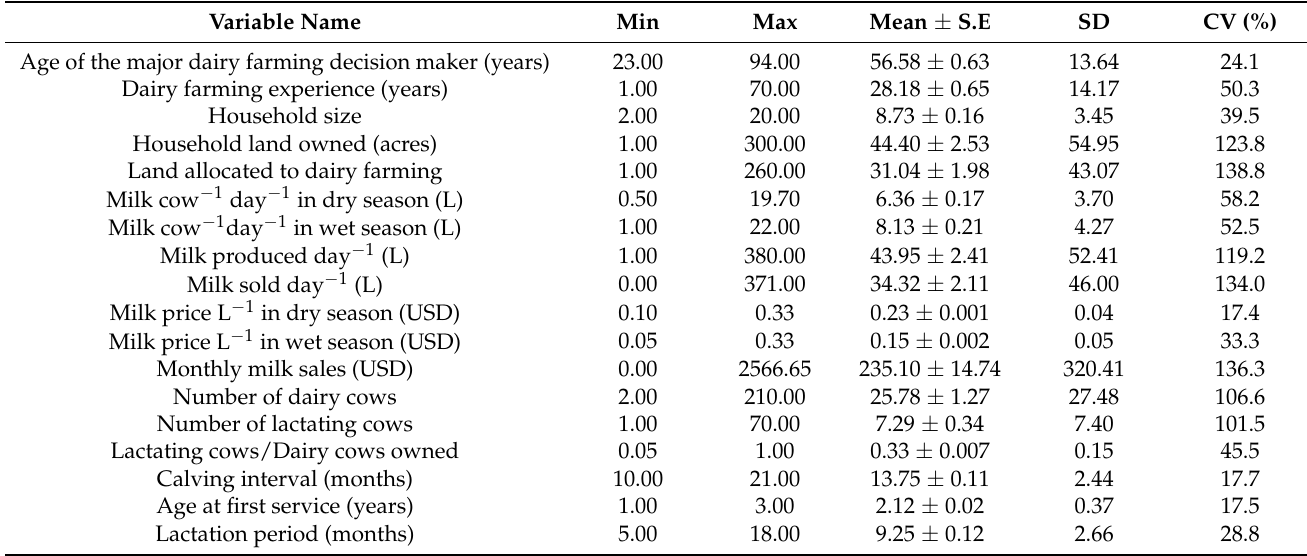
Table 2. General characteristics of the sampled dairy cattle